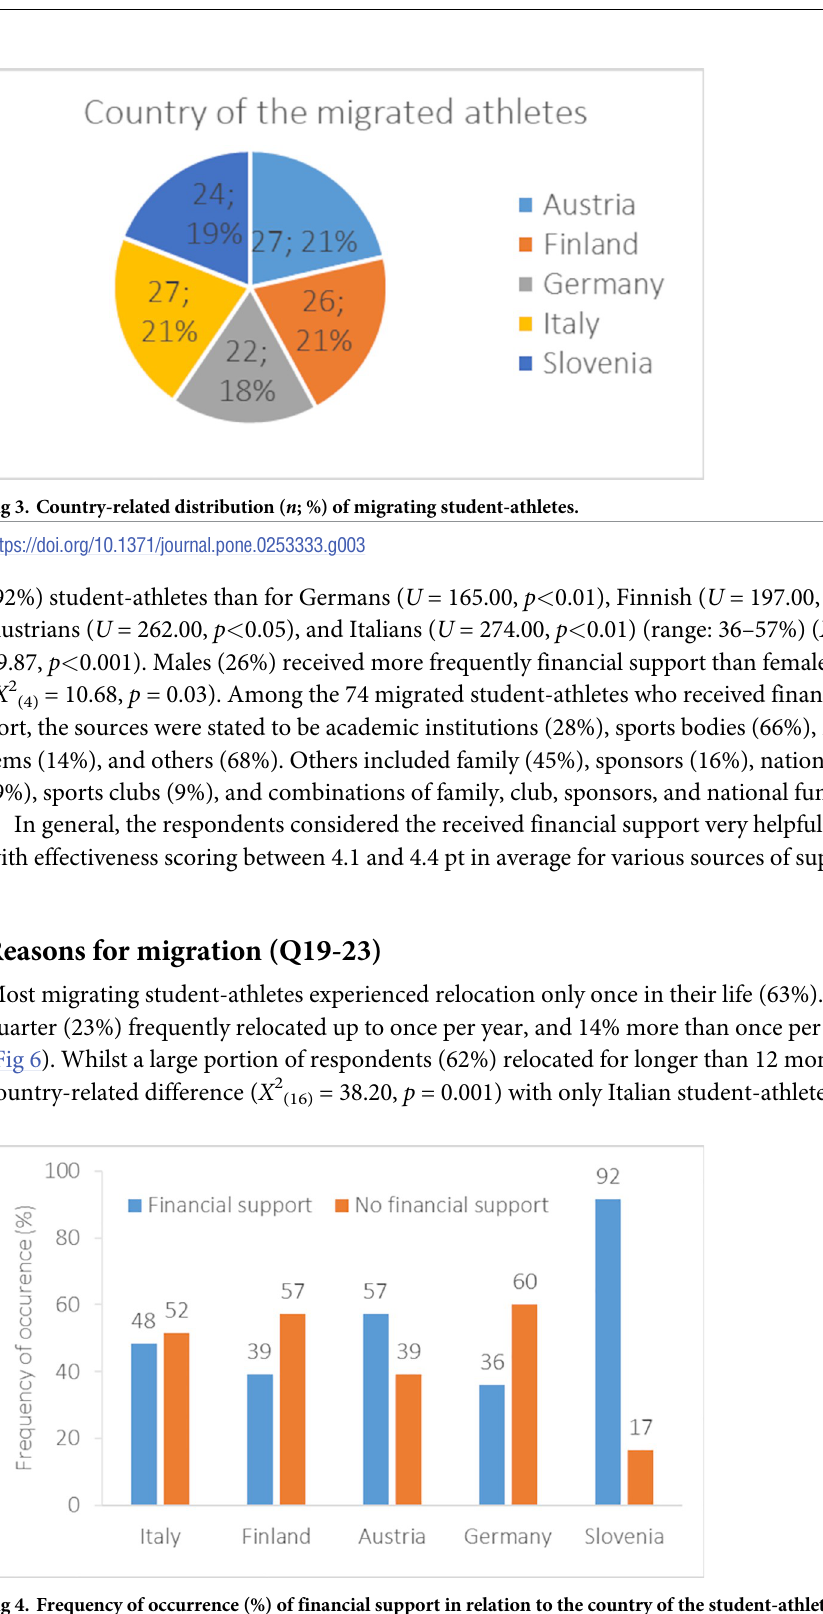
Fig 4. Frequency of occurrence (%) of financial support in relation to the country of the student-athletes.